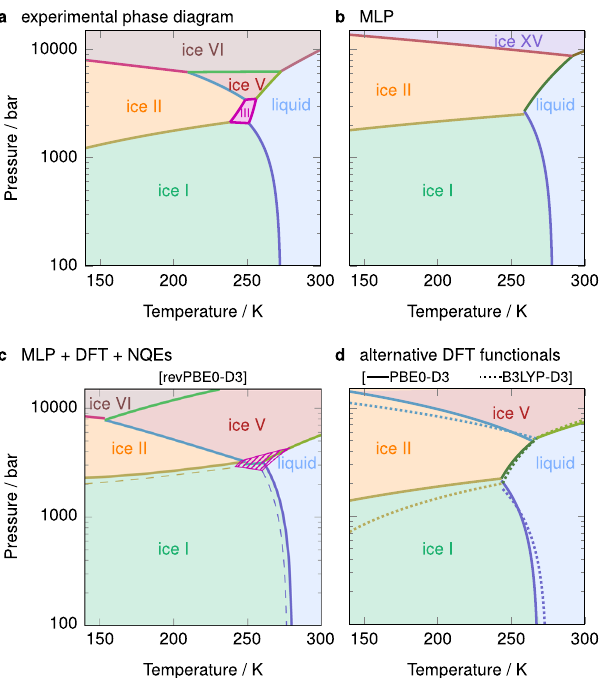
Fig. 3 Comparison of phase diagrams. Phase diagrams a from experiment 64, 65 and b – d from simulation. The phase diagram in b corresponds to the classical system described by the MLP, while c , d are at the indicated DFT levels and also account for NQE corrections. Dashed lines in c correspond to an alternative calculation where the chemical potential of ice III was decreased and that of ice I was increased by the typical error in chemical potential calculations (Fig. 2d), as discussed in the text. The hatched area corresponds to the region of stability of ice III in this alternative calculation.